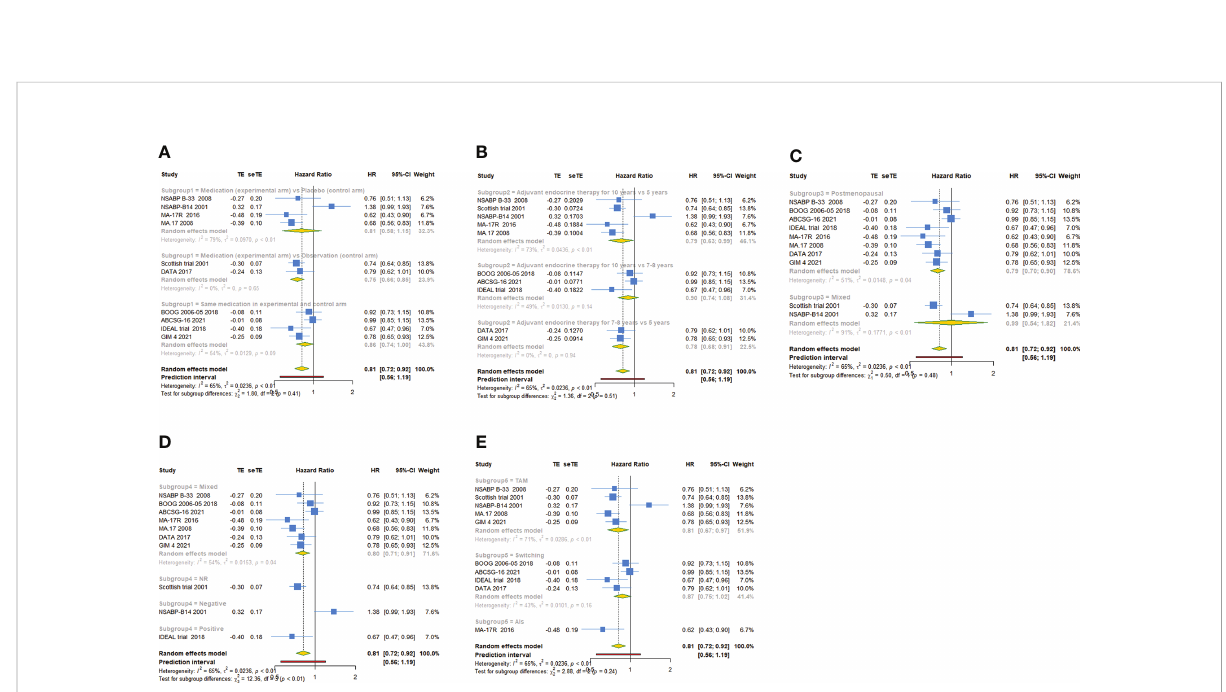
FIGURE 3 Forest plot of subgroup analysis of extended adjuvant endocrine therapy for disease-free survival (DFS). (A) Subgrouped by the extended treatment method in experimental and control arm; (B) subgrouped by the duration of adjuvant endocrine therapy; (C) subgrouped by menopausal state of patients; (D) subgrouped by lymph node positive/negative; (E) subgrouped by the type of prior endocrine